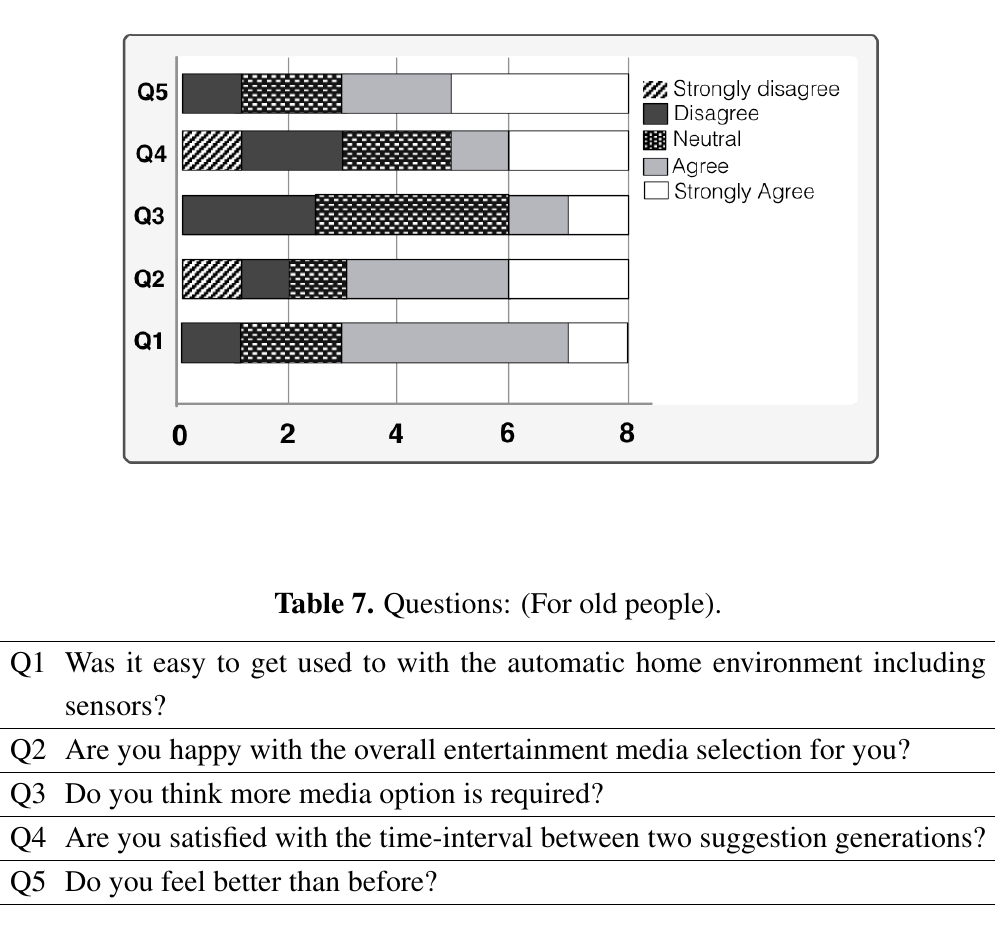
Figure 11. Caregiver feedback based on the questioner listed in Table 8.